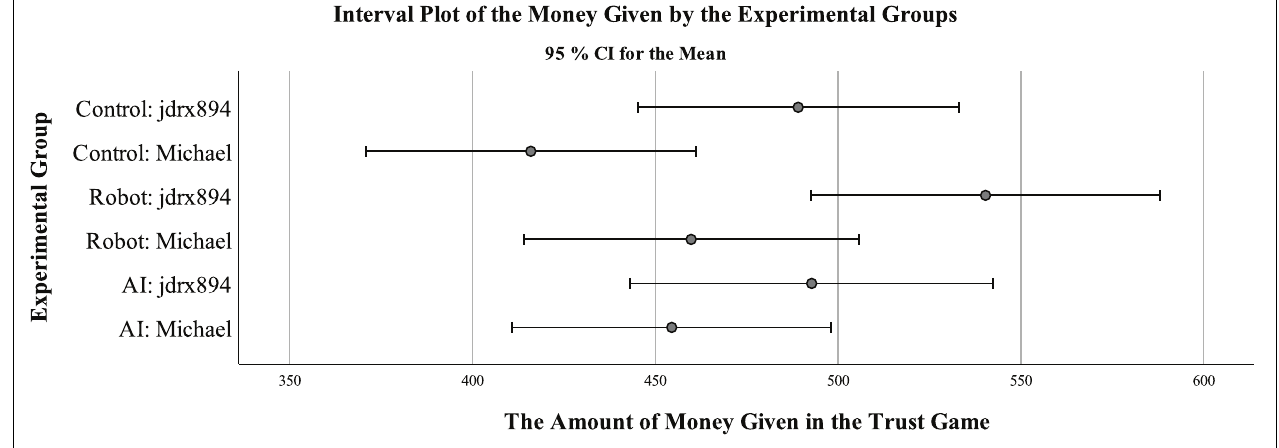
FIGURE 1 | Trust game mean values (95% CI) on a scale of 0–1000 by experimental groups in Study 1 ( N = 1077).